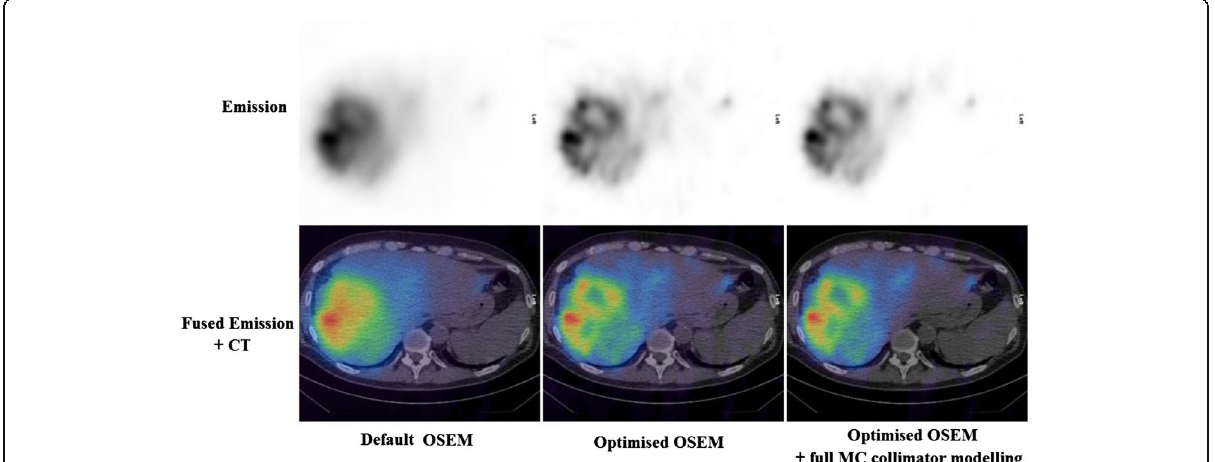
Fig. 4 Transaxial slices showing distribution of microspheres in the liver of a patient. Left: default OSEM (2 iterations, 10 subsets); middle: optimised OSEM (5 iterations, 15 subsets); right: optimised OSEM with full MC collimator